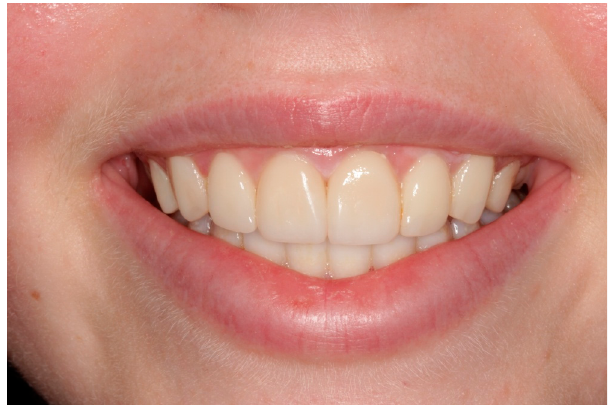
Figure 3. Case 1 postoperative smile photograph.